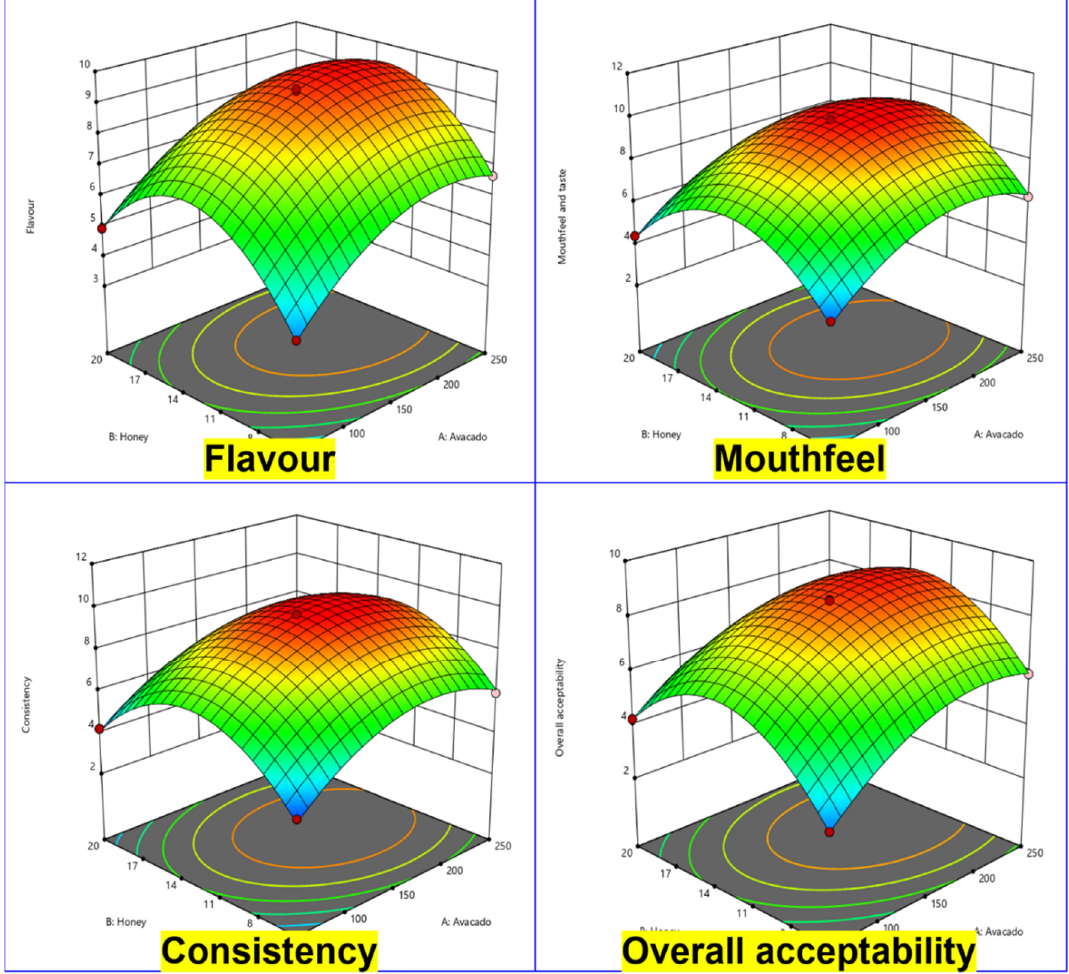
Figure 1. Surface plot represents the flavor attributes of mouthfeel and taste attributes, consistency attributes and overall acceptability attributes of avocado fruit pulp juice formulation.